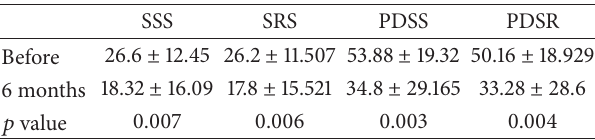
Table 5: Perfusion